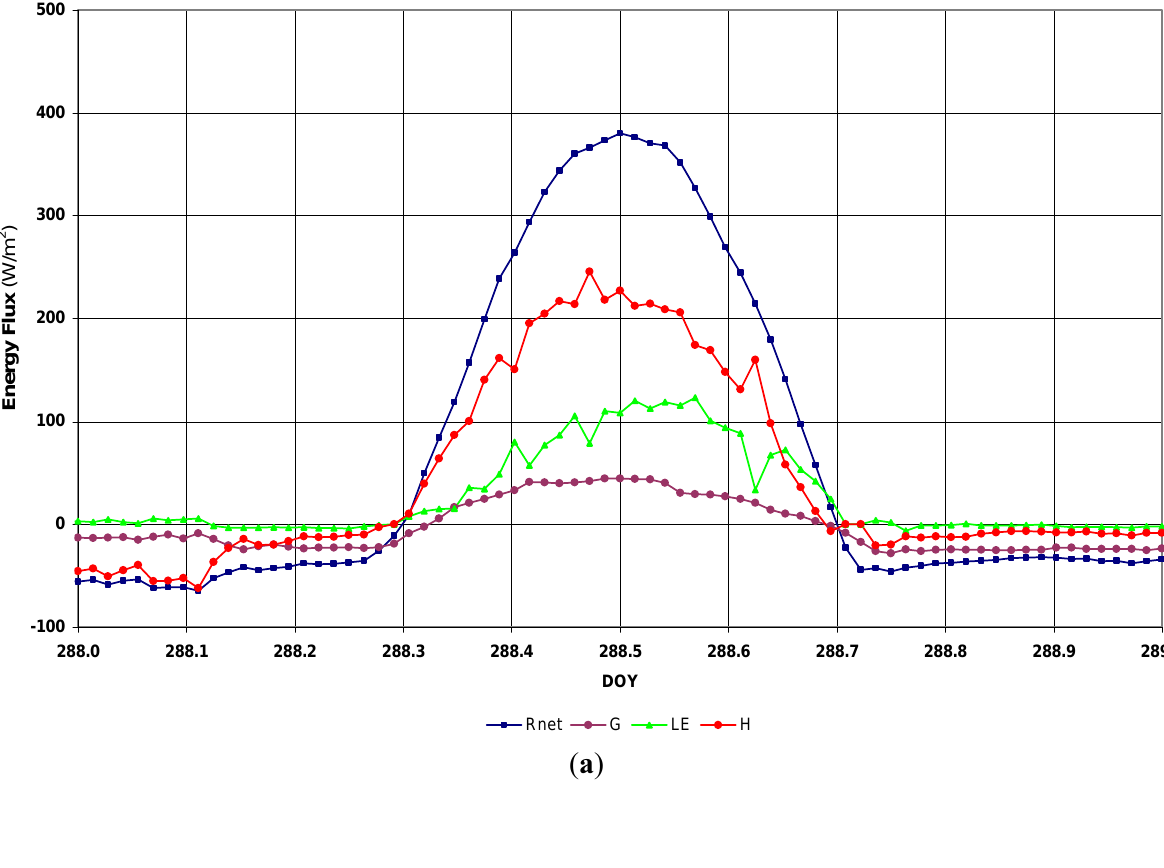
Figure 5. Energy balance for net radiation ( R ), soil heat flux ( G ), sensible heat flux ( H ), net and latent heat flux (or evapotranspiration) ( LE ) every 20-min measured by the Bowen ratio system at ( a ) KL03 unirrigated pasture site and ( b ) KL04 irrigated pasture site for DOY 288 (14 October)